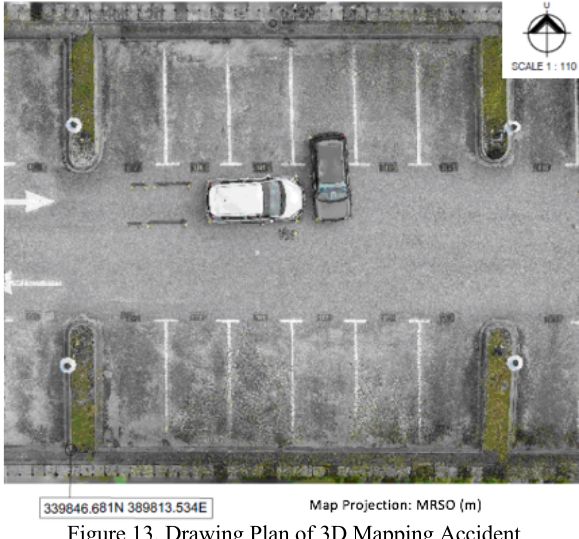
Figure 13. Drawing Plan of 3D Mapping